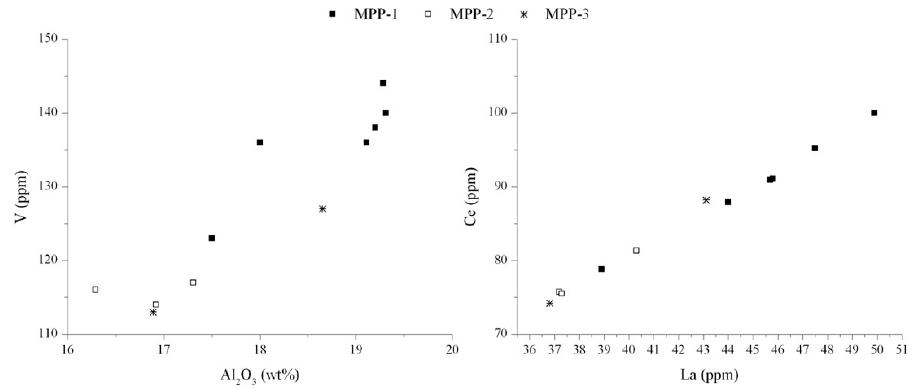
Figure 8. Binary diagrams of V-Al 2 O 3 and La-Ce for the studied western Greek amphorae.